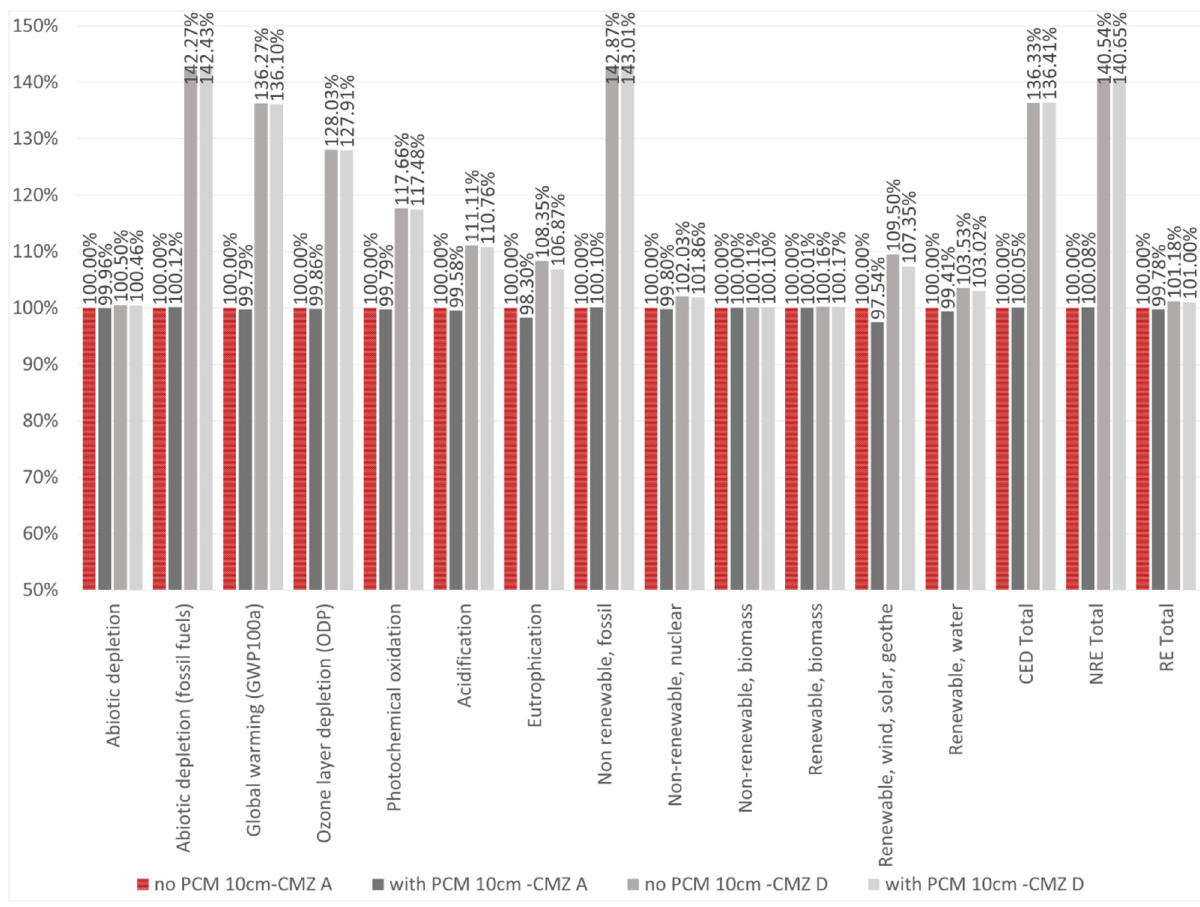
Fig. 5. Comparative analysis for the use of PCMs, per impact indicator, for the two CliMate Zones (CMZ: A and D) of Greece (the values are given in reference to the base case scenario: no PCM, 10 cm XPS thickness, zone A, red coloured hatch